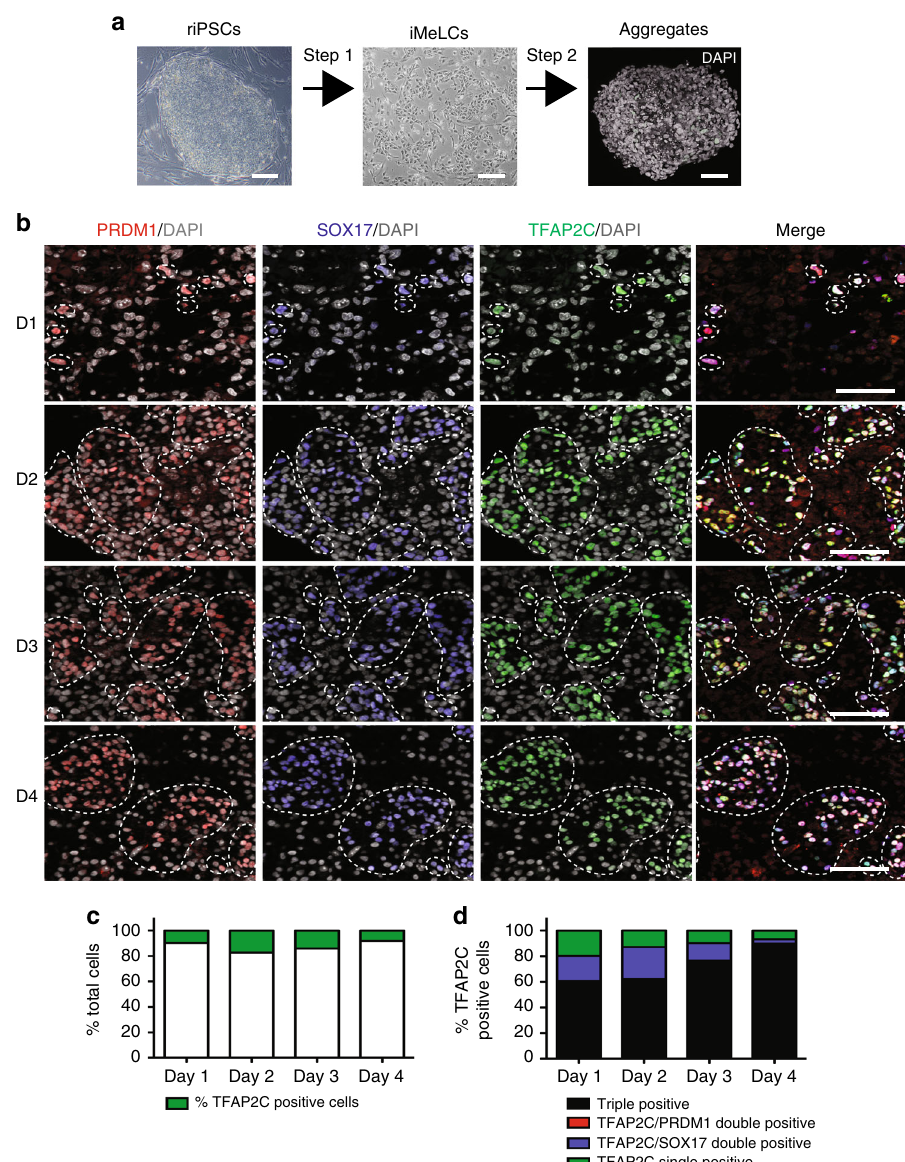
Fig. 2 Speci fi cation of rPGCLCs from riPSCs. a Schematic overview of rPGCLC-speci fi cation in aggregates via an iMeLC intermediate. Scale bars = 100 µ m, shown are images of riPSC89 differentiation. b Triple IF staining for germ cell markers during riPSC89 aggregate differentiation from Day (D) D1 through D4. PRDM1 (red), SOX17 (blue), TFAP2C (green), DAPI (gray). Dotted lines highlight TFAP2C positive cells (single and clusters). Scale bars, 50 µ m. N = 3 biological replicates. c The percent of TFAP2C positive cells (green) in aggregates at D1 – D4. d The percent of TFAP2C positive cells in aggregates at D1 – D4 that are either single (TFAP2C, green), double (TFAP2C/PRDM1, red or TFAP2C/SOX17, blue), or triple (TFAP2C/PRDM1/SOX17, black) positive for early rPGC markers. Shown are results using the riPSC90 cell line, unless otherwise